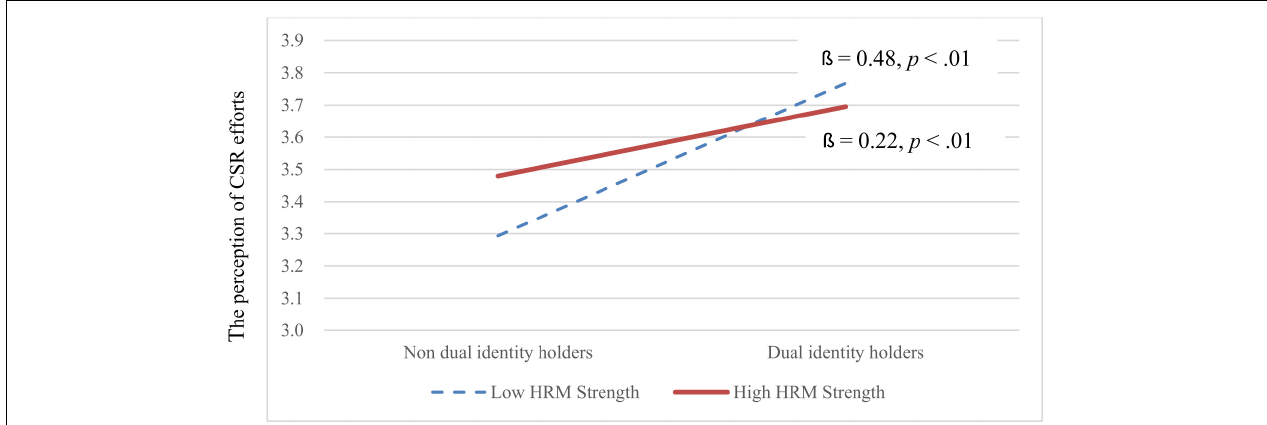
of internal CSR efforts under low ( β = 0.48, p < 0.01) and high ( β = 0.22, p < 0.01) HRM strengths. However, the relationship was significantly stronger under weak HRM. Similarly, Hypothesis 6 was supported ( γ = − 0.39, p < 0.05).